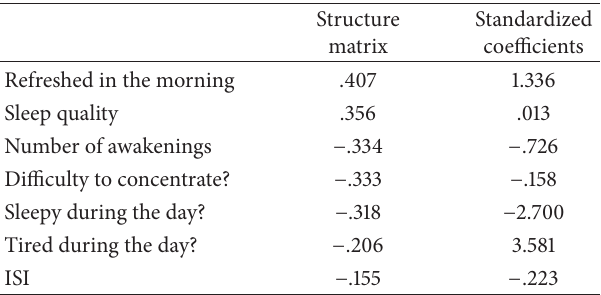
Table 5: Sleep-related predictors for adherent and nonadherent